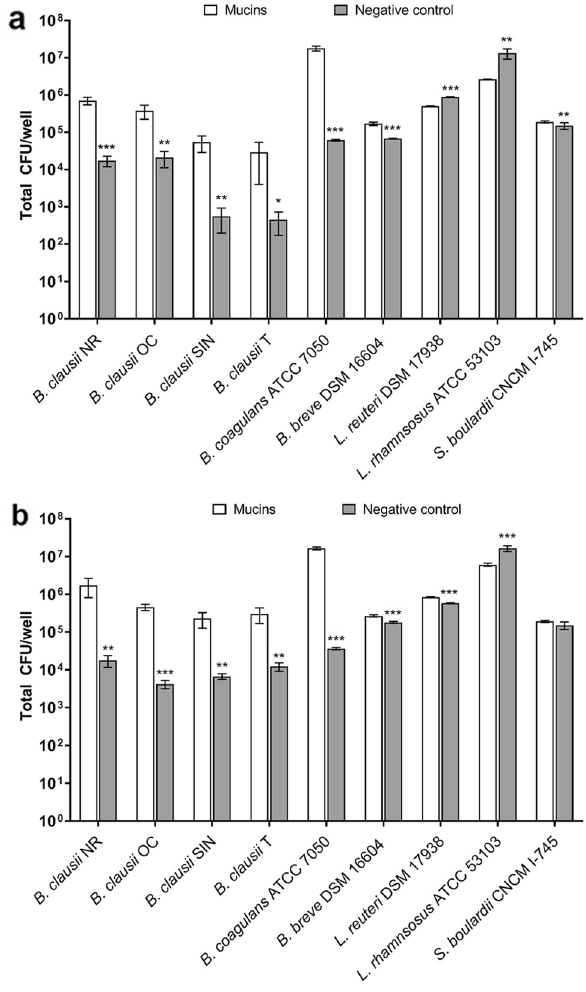
Figure 2. Adhesion of probiotic microbes to porcine mucins. ( a ) Amount of cells (CFU/well) mechanically extracted from agar containing mucins (open bars) and from agar without mucins (i.e. negative control, grey bars) after incubation at 37 °C in aerobiosis. ( b ) Amount of cells (CFU/well) mechanically extracted from agar containing porcine mucins (open bars) and from agar without mucins (i.e. negative control, grey bars) after incubation at 37 °C in anaerobiosis. Three independent biological replicates with two technical replicates each were performed. Data are expressed as the mean ± standard deviation. For each strain, the two-tailed Student’s t-test was used to compare the CFU/well obtained on mucins and negative control wells. *P < 0.05, **P < 0.01, ***P <